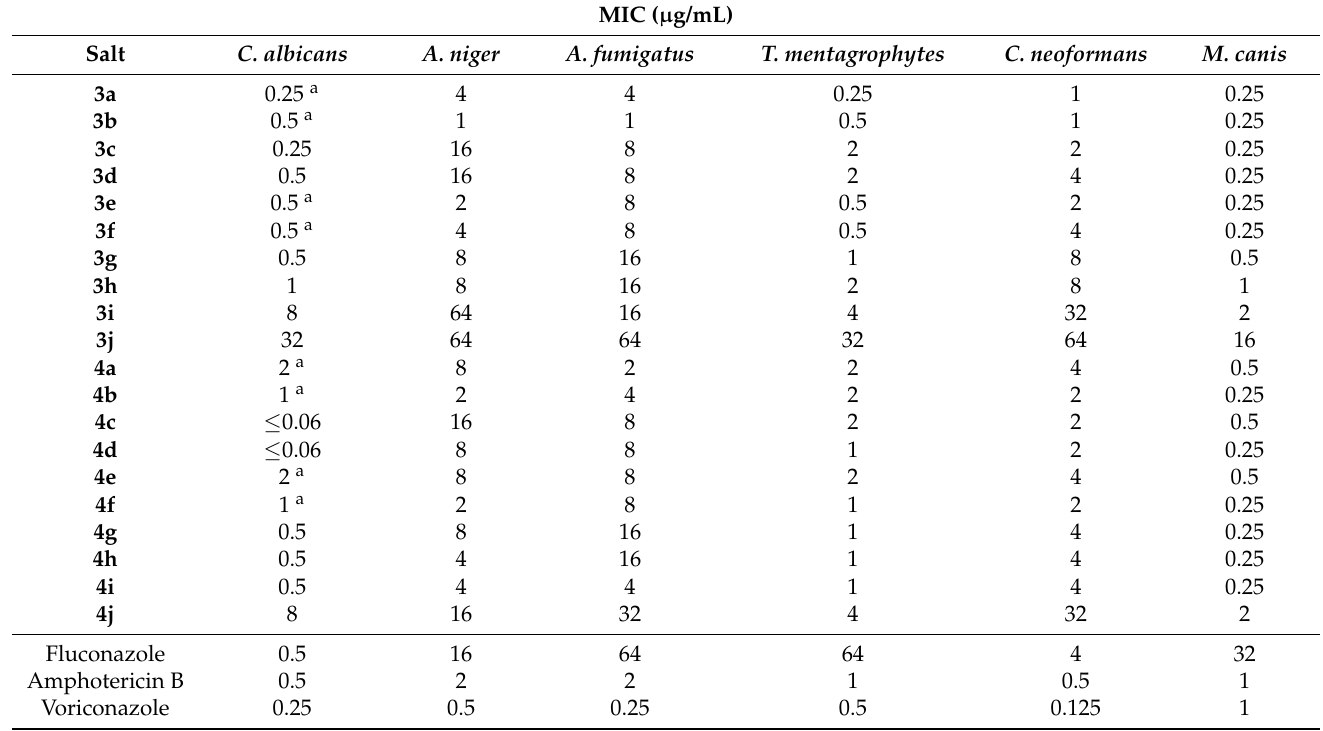
Table 3. Minimum inhibitory concentration (MIC) values of imidazolium salts against fungal